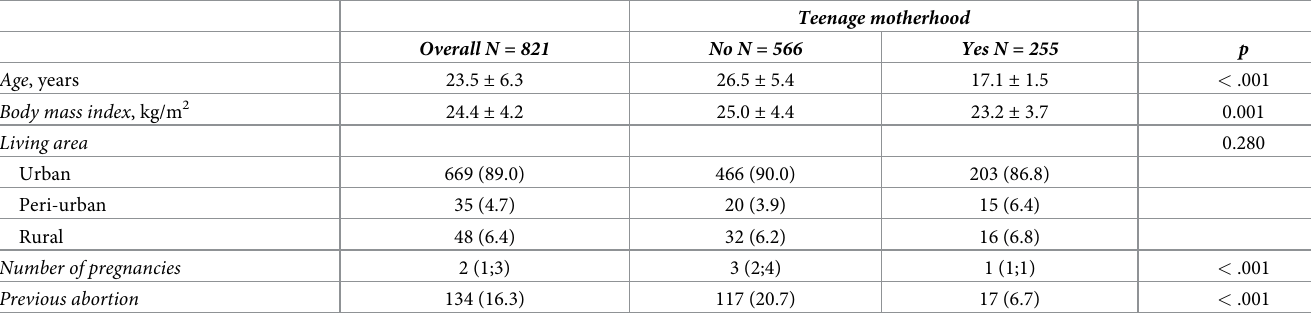
Table 1. Characteristics of the